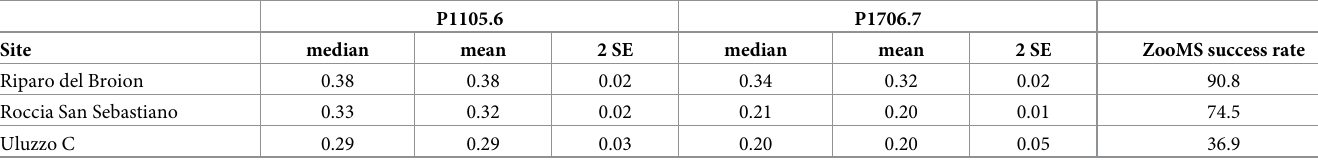
Table 4. Deamidation medians and means for the two peptides taken into consideration (peptides with m/z 1105.6 and P1706.7) with the respective 2-standard error (reported as 2 SE) and the ZooMS taxonomic determination success rate in the taxonomic determination for all the analysed